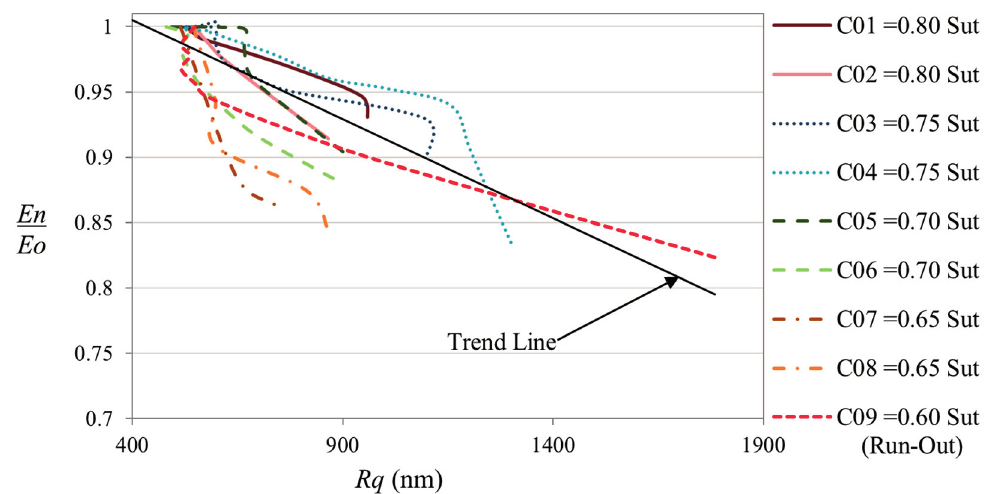
Figure 8. Correlation between stiffness degradation and surface roughness magnitude ( Rq ) at VALs. The trend line is obtained combining the roughness and stiffness data of all the